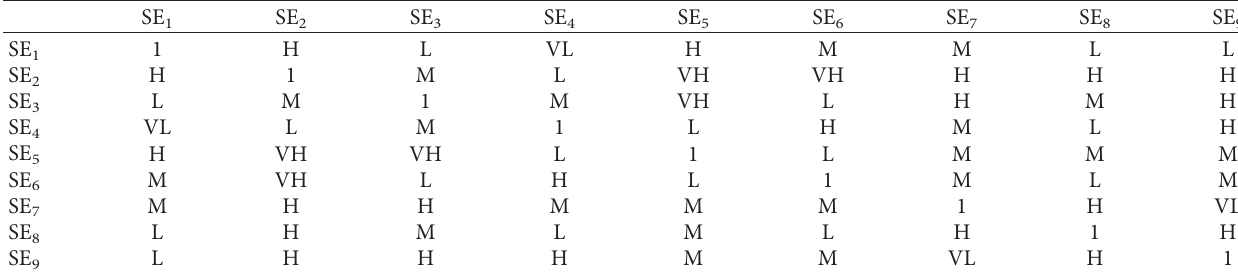
Table 7: Autocorrelation matrix of express SEs.